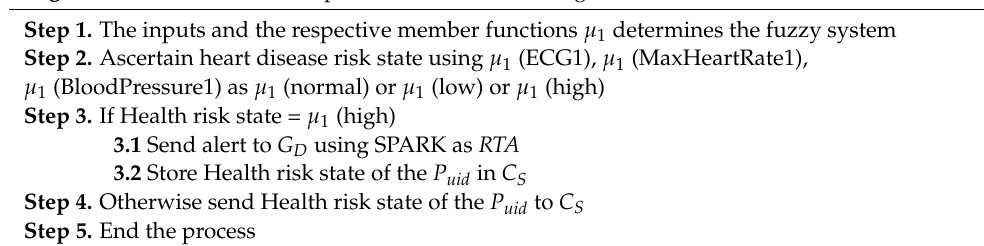
Algorithm 1 : Classification of patients’ health data using FIS.